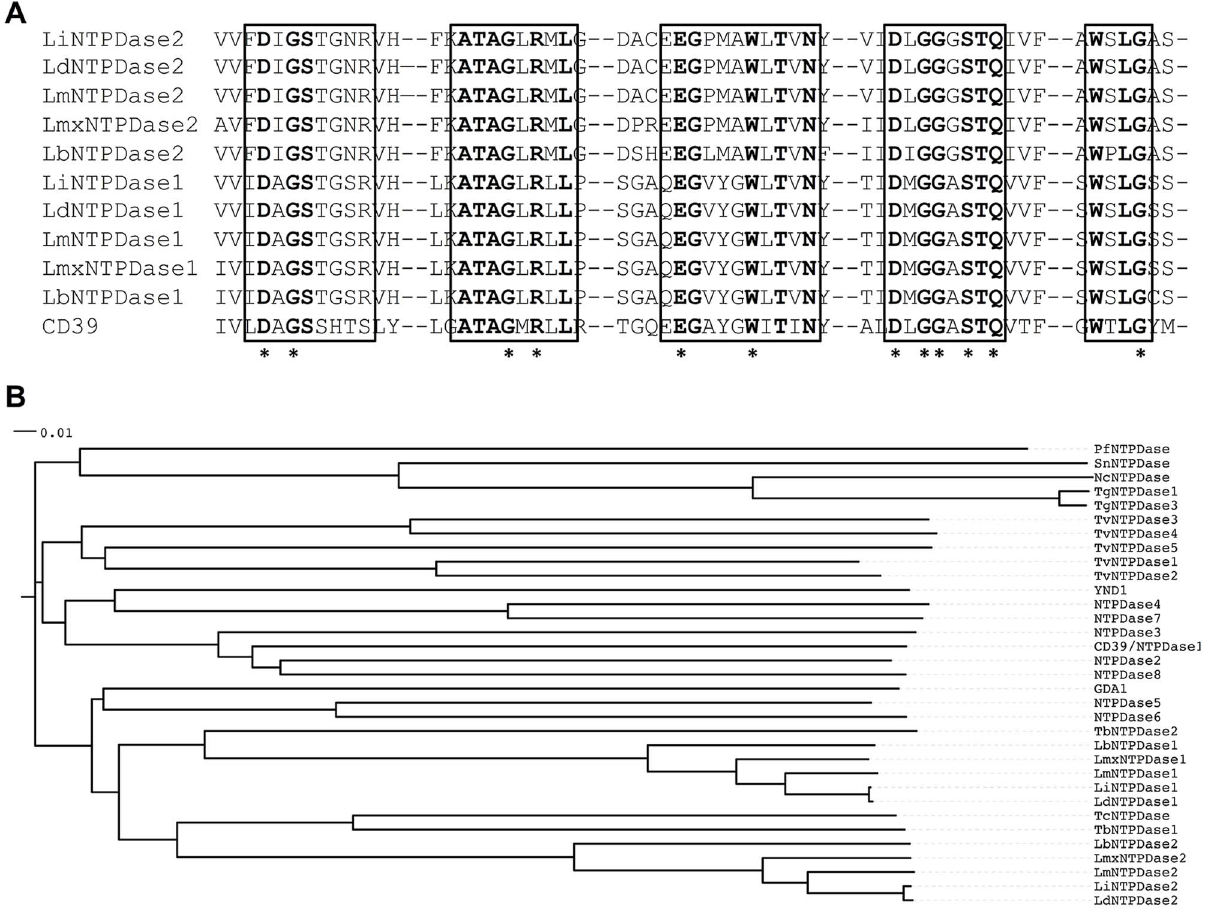
Fig. 1. A. Alignment of regions of the putative Leishmania NTPDases with human CD39 (NTPDase1). The conserved ACRs are aligned and boxed, with absolutely conserved residues shown in bold. Residues known to be necessary for enzyme function in mammalian NTPDases are starred, revealing all are present in the putative Leishmania NTPDases. Alignment was performed using ClustalW [27,28]. B. Phylogenetic tree of protozoan, yeast and mammalian NTPDases. The tree was constructed from a ClustalW alignment of NTPDase amino acid sequences and viewed and edited using the Interactive Tree of Life web tool [63,64]. Sequence accession numbers used for Fig. 1A and 1B are given in supplementary S2 Table.